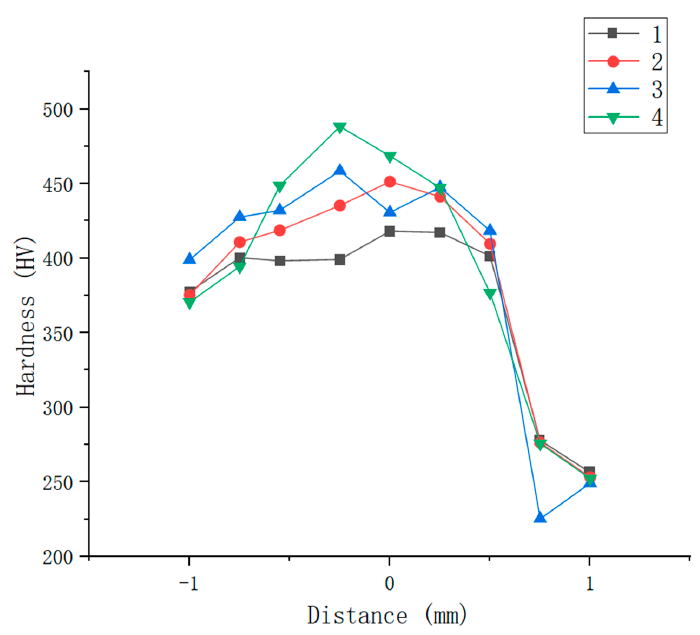
Figure 9. Microhardness curve of the welds of the four samples.